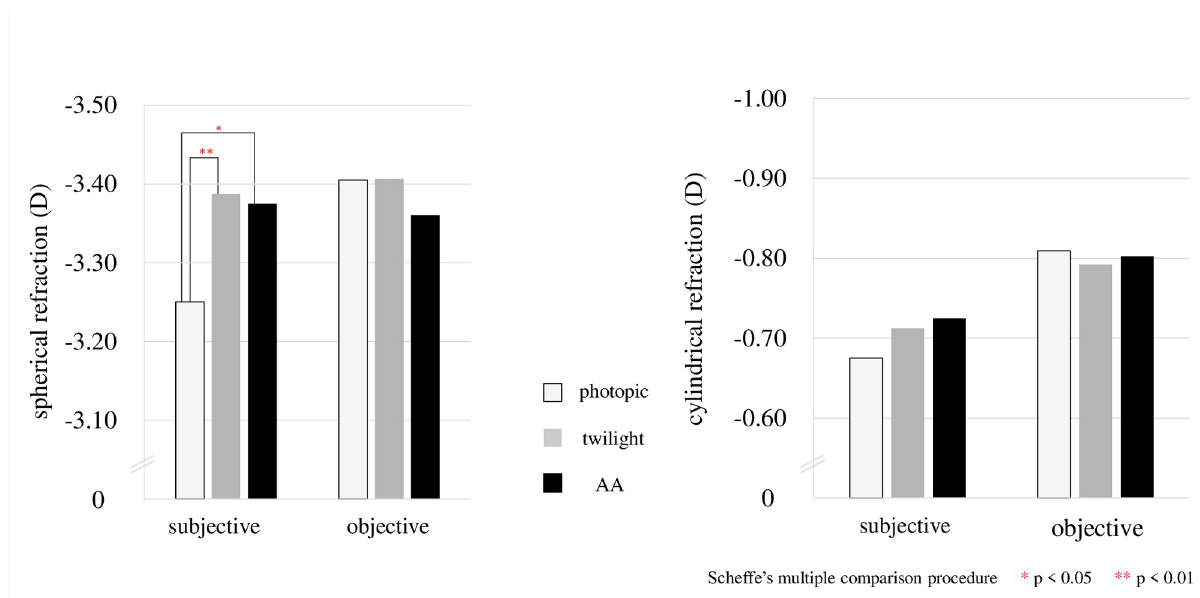
Fig 4. Enlarged comparison of the results shown in Fig